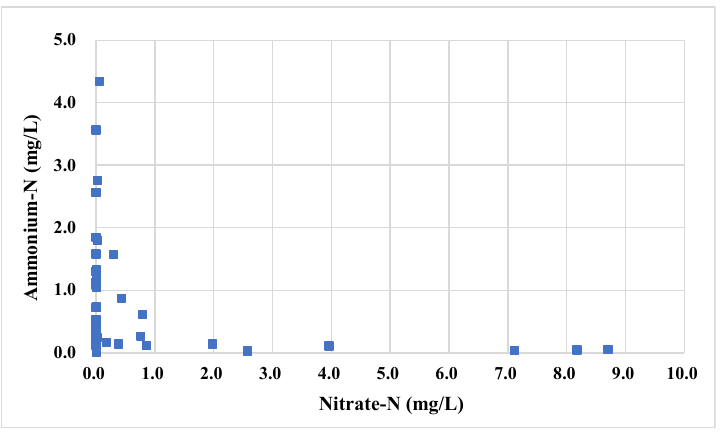
Figure 9. Scatter plot of recent 3-year average concentrations of ammonium–N and nitrate–N in each well. Scatter plots of ammonium–N concentration vs. DO and nitrate–N concentration vs.